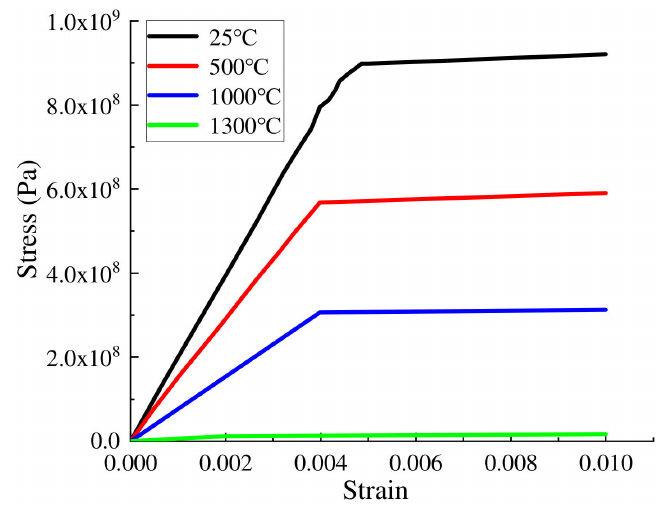
Figure 3. Stress–strain curves of the material in Model I according to temperature.